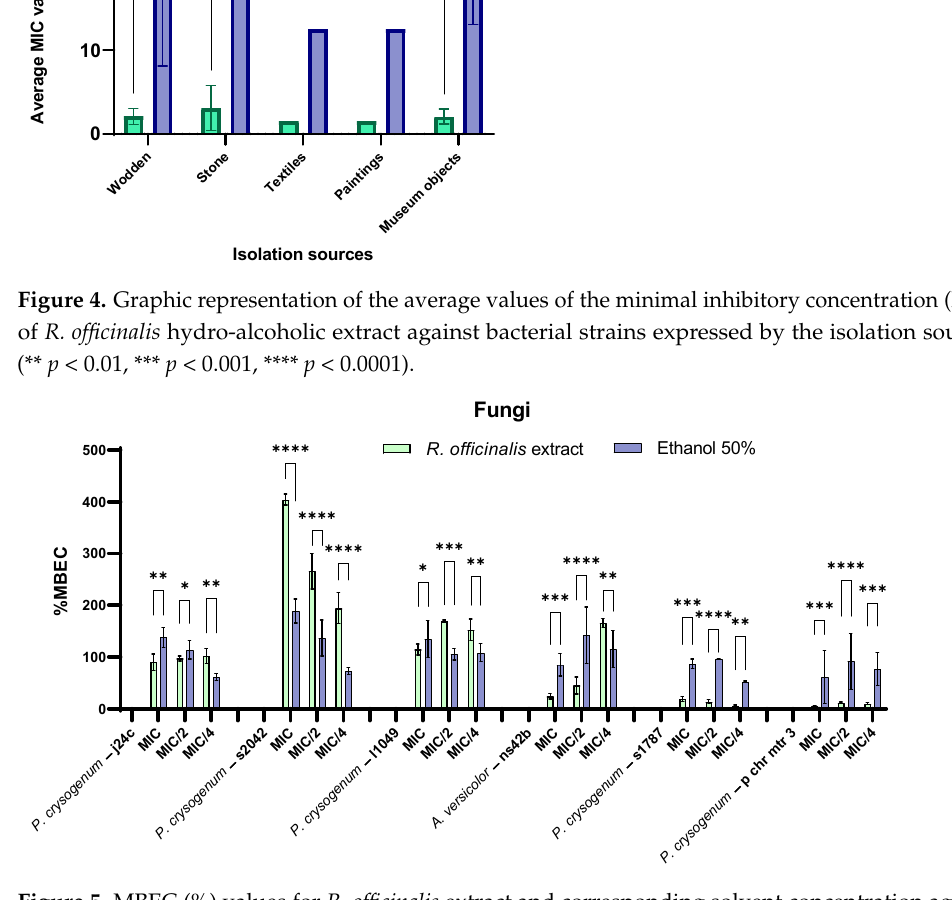
Figure 5. MBEC (%) values for R. officinalis extract and corresponding solvent concentration against fungal biodeterioration strains (* p < 0.05, ** p < 0.01, *** p < 0.001, **** p < 0.0001). According to Figure 6, the chemical compounds from the composition of R. officinalis have also inhibited by different degrees the biofilm developed by the three selected bac- terial strains, as revealed by the low MBEC values, the anti-biofilm effect depending on the bacterial species and the tested concentration. This might possibly be explained by the different composition of biofilm matrix formed by different bacterial strains, influencing the rate of anti-biofilm compounds diffusion inside the bacterial biofilm. Thus, for B. pu- milus , the best anti-biofilm activity was recorded at MIC/2, followed by MIC/4, for B. thu- ringiensis at the MIC value and for P. koreensis , all tested concentrations exhibited an anti- adherence effect, although not statistically significant as compared to the solvent.